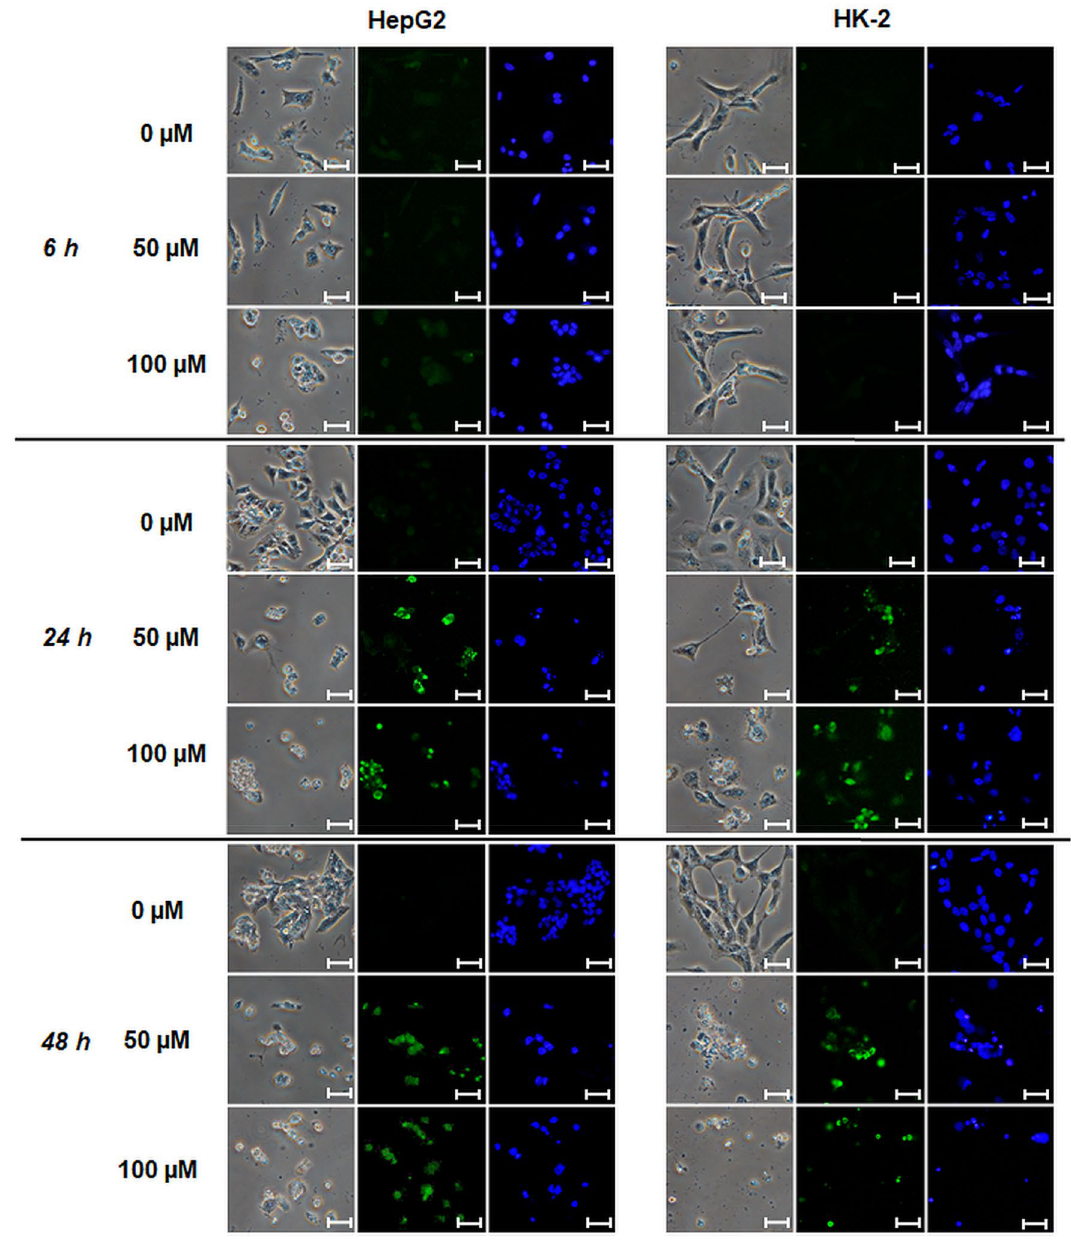
Figure 5. TUNEL assay in CisPt treated cells. HepG2 and HK-2 cells were treated with CisPt (50 and 100 µM) for 6, 24 and 48 h. Then, the cells and nuclei were visualized using phase contrast (left, magnification 400 ×), TUNEL (FITC 480/30 nm; middle) and Hoechst 33258 stainings (DAPI 375/28 nm; right). Scales correspond to 25